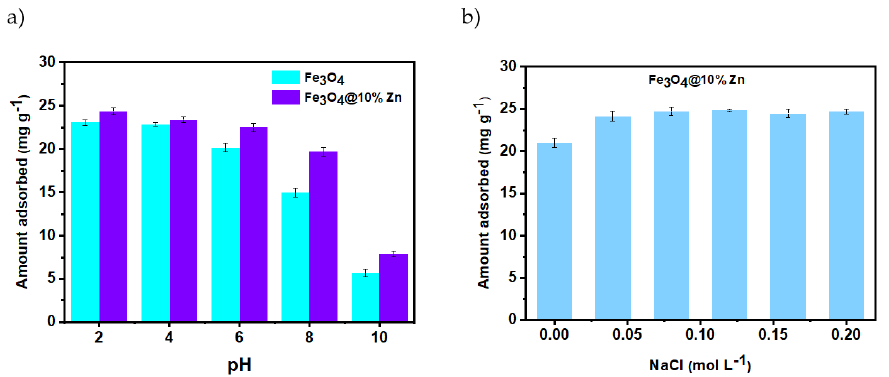
Figure 13. The effect of pH ( a ) and the ionic strength ( b ) on the adsorption of Titan